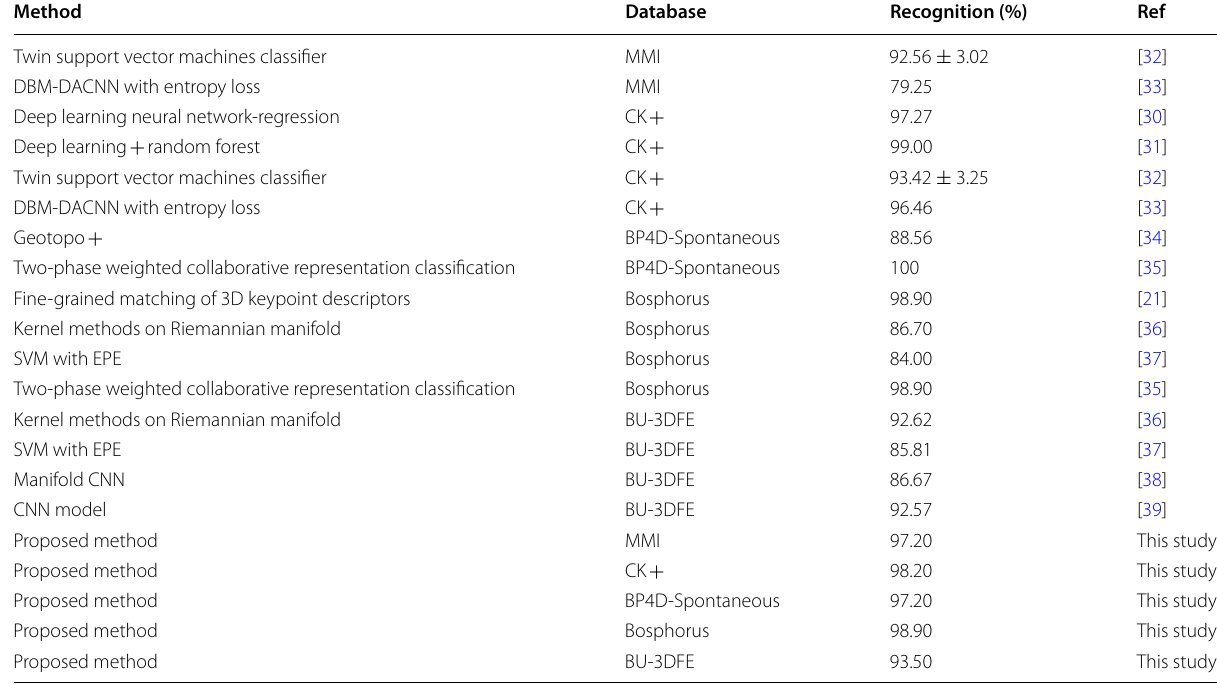
Table 2 Comparison of results on different